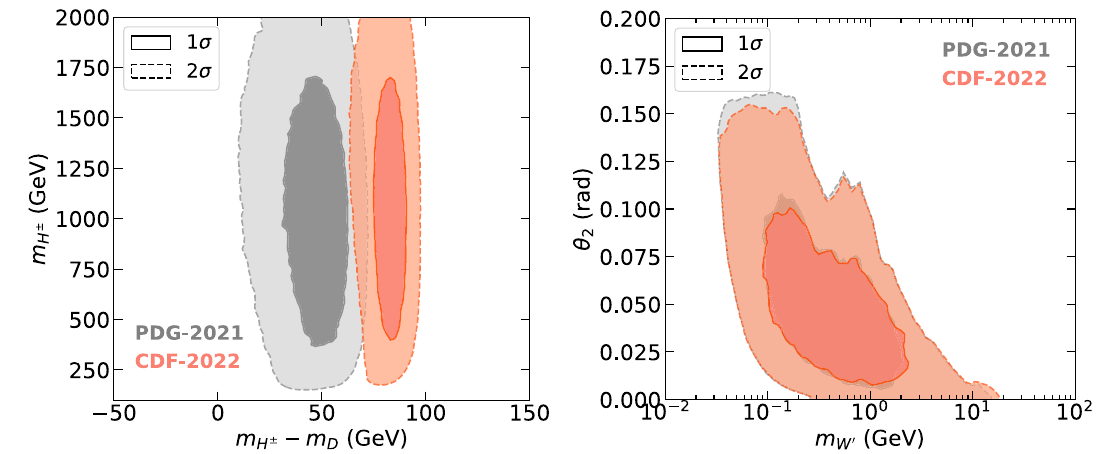
Fig. 11 The favored regions projected on the planes of ((cid:5) m ≡ m H ± − m D , m H ± ) (left panel) and ( m W (cid:3) ,θ 2 ) (right panel) for the light DM mass scenario. The dark (light) orange region represents the 1 σ (2 σ ) favored by CDF-2022 , while the dark (light) gray region indicates the 1 σ (2 σ ) favored by the